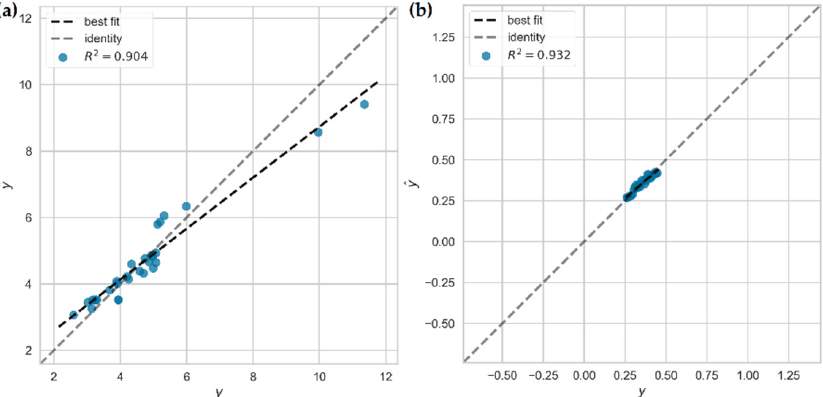
Figure 8. Correlation heatmap between the process parameters and the responses.